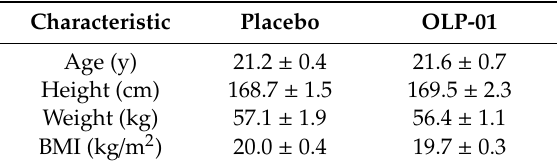
Figure 1. Experimental design. We used a double-blind test in which volunteers (21 subjects; 14 males and seven females) were assigned to two groups: a placebo group and an OLP-01 (1.5 × 1010 colony forming units (CFU) / day) group. They completed a five-week intervention consisting of three weeks of regular training and two weeks of de-training, and their physical fitness, physiological adaptations, and fecal samples were analyzed before and after the experimental intervention. Table 1. Basic information data of the subjects.